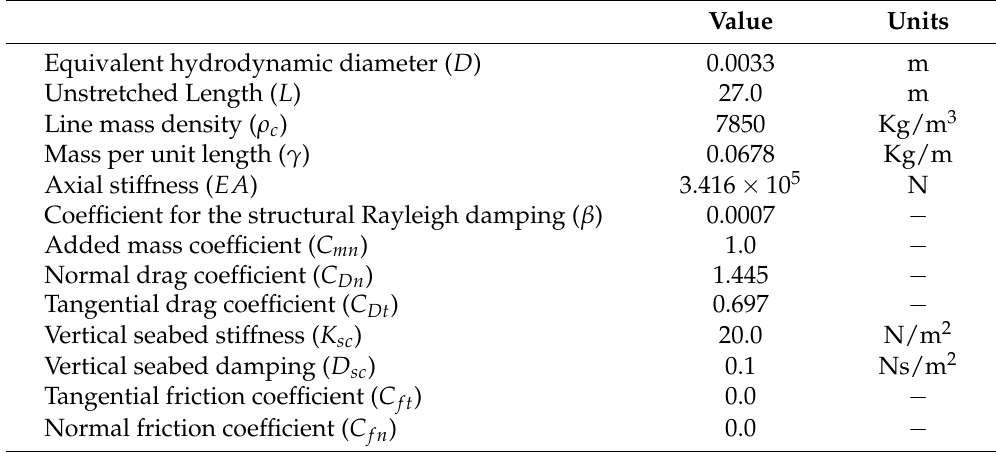
Table 7. Parameters of the computational model.